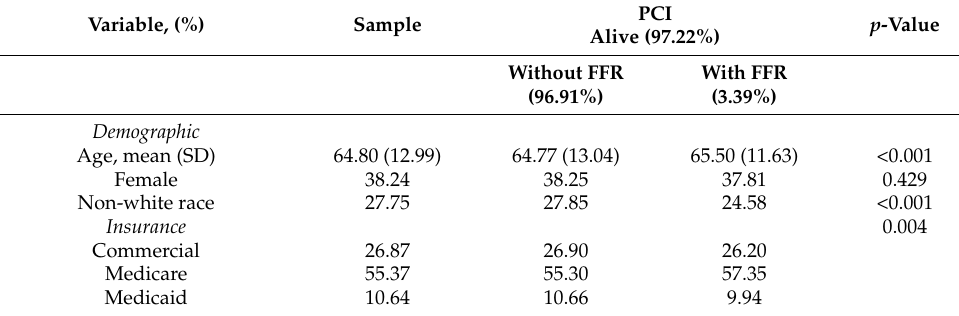
Table 1. Demographic statistics and bivariable analysis by PCI with versus without FFR ( n =